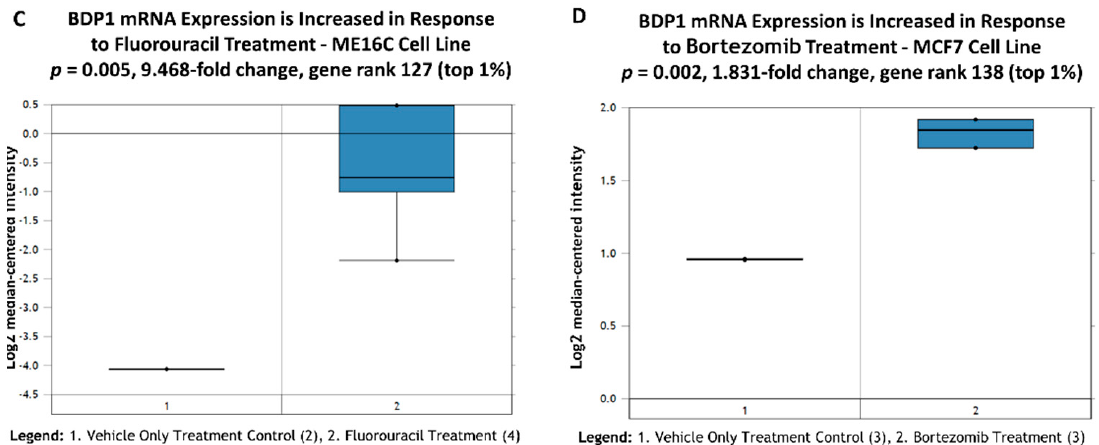
Figure 6. Breast cancer chemotherapeutics increase BDP1 mRNA expression. A query of the Troester [35] and Nickeleit [36] cell line datasets for BDP1 mRNA expression in ME16C and MCF7 cells in response to ( A ) doxorubicin, ( B ) etoposide, ( C ) fluorouracil, or ( D ) bortezomib treatment. p -values, fold-change, and gene rank are indicated in the figure. Detailed methods are provided in the published papers by Troester et al. [35] and Nickeleit et al. [36]. Bright blue denotes statistically signifi- cant BDP1 changes. The Oncomine™ Platform (Thermo Fisher, Ann Arbor, MI, USA) was used for analysis and visualization.